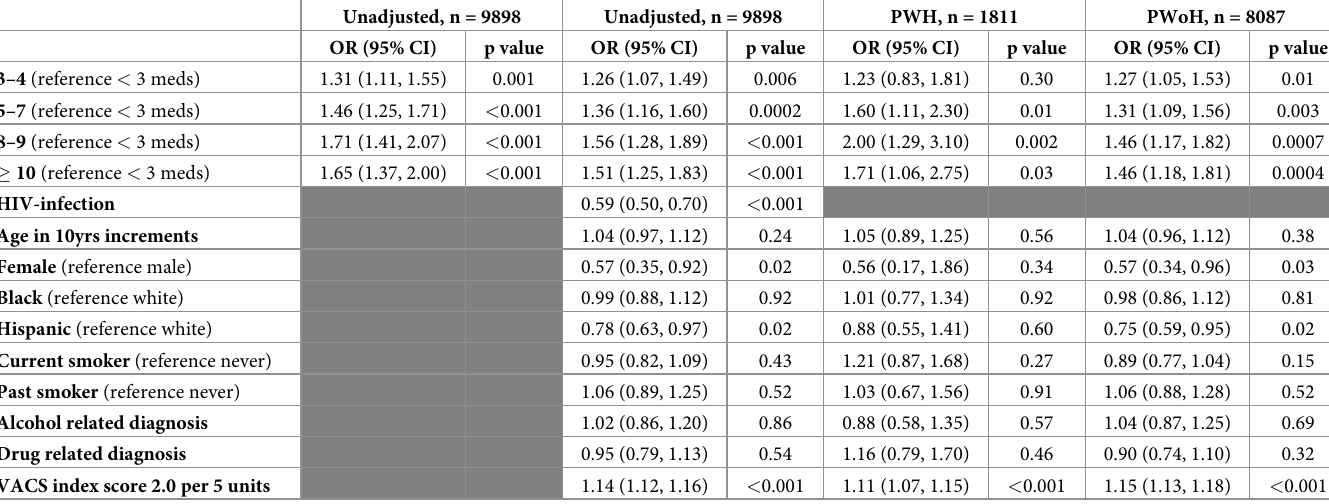
Table 4. Logistic regression models looking at increments of medication based on restricted cubic spline regression and MICU